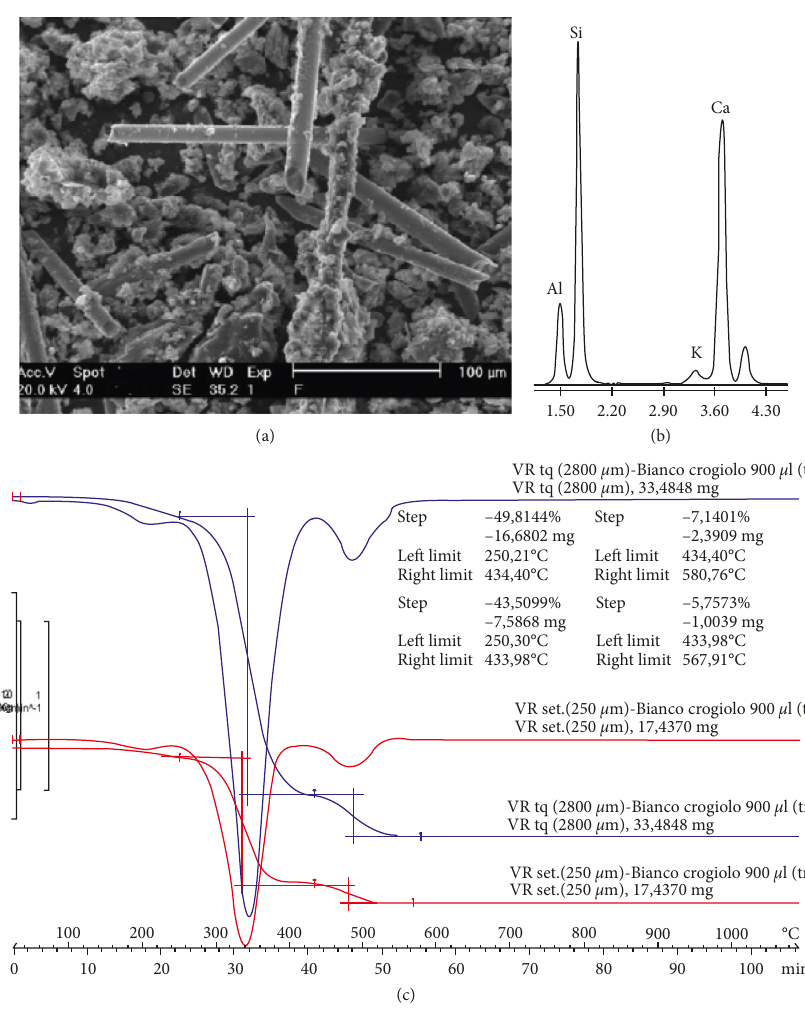
Figure 3: (a) SEM [31, 33] and (b) EDAX analysis of GRPd [31, 33]. (c) DT/TG analysis of GRPd before (upper curve) and after (lower curve) sieving at 250 μ m. Figures 3(a) and 3(b) are reproduced from Tittarelli and Moriconi [31] and from Tittarelli and Shah [33] under